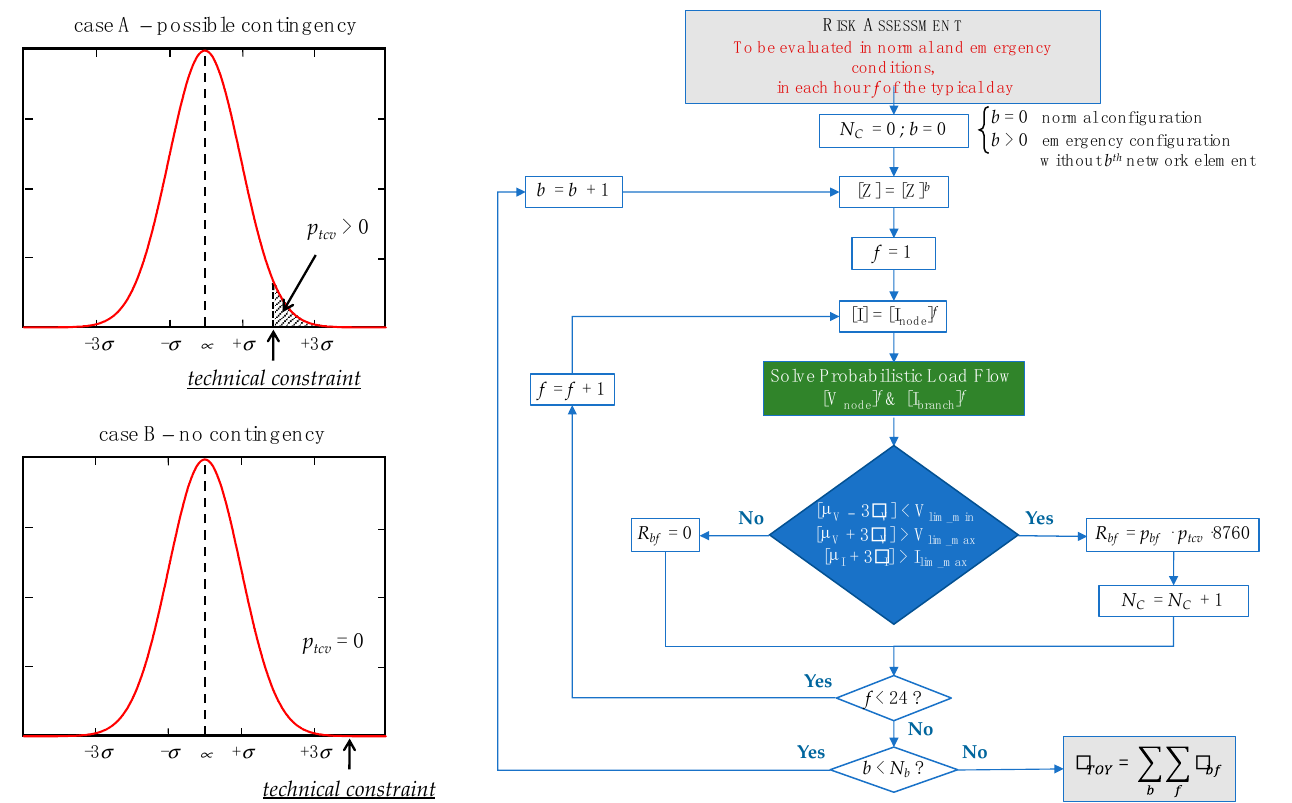
Figure 3. Identification of potential contingencies ( p tcv ) and procedure for the total risk assessment.